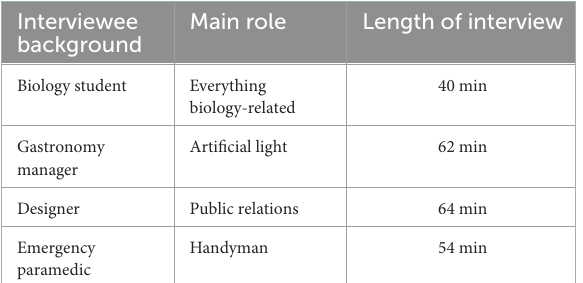
TABLE 3 Overview of interviewees involved in the Farmbox. TABLE 4 Structure and goals of the semi-structured